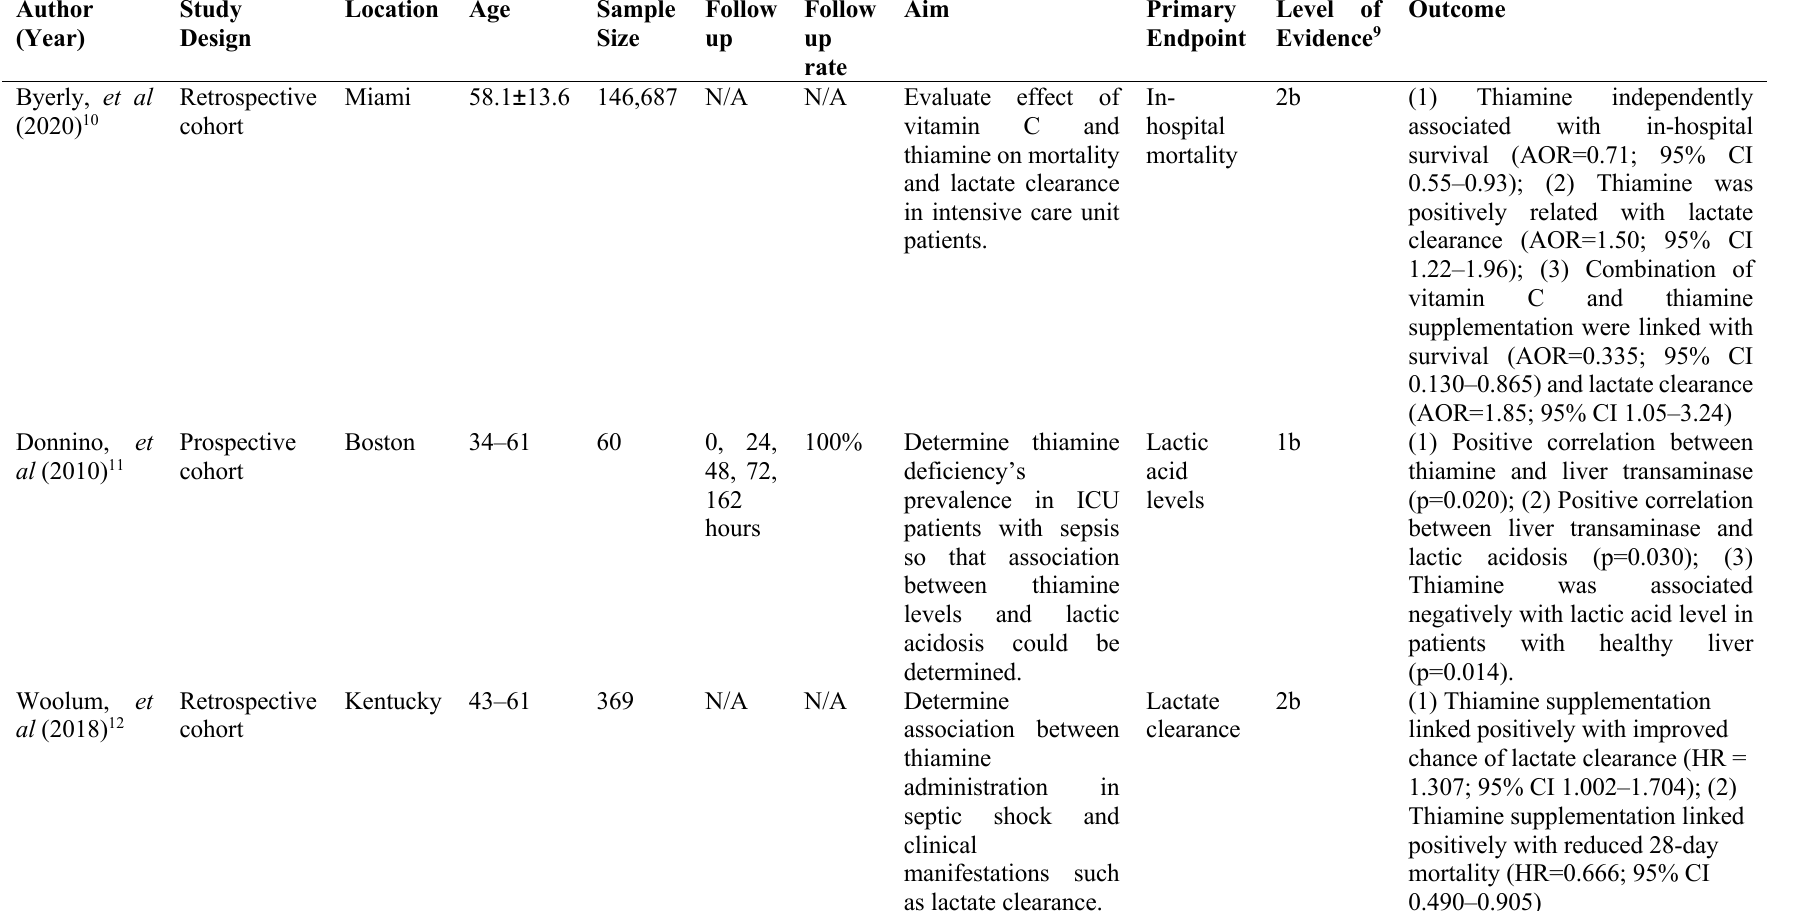
Table 2. Characteristic of selected studies